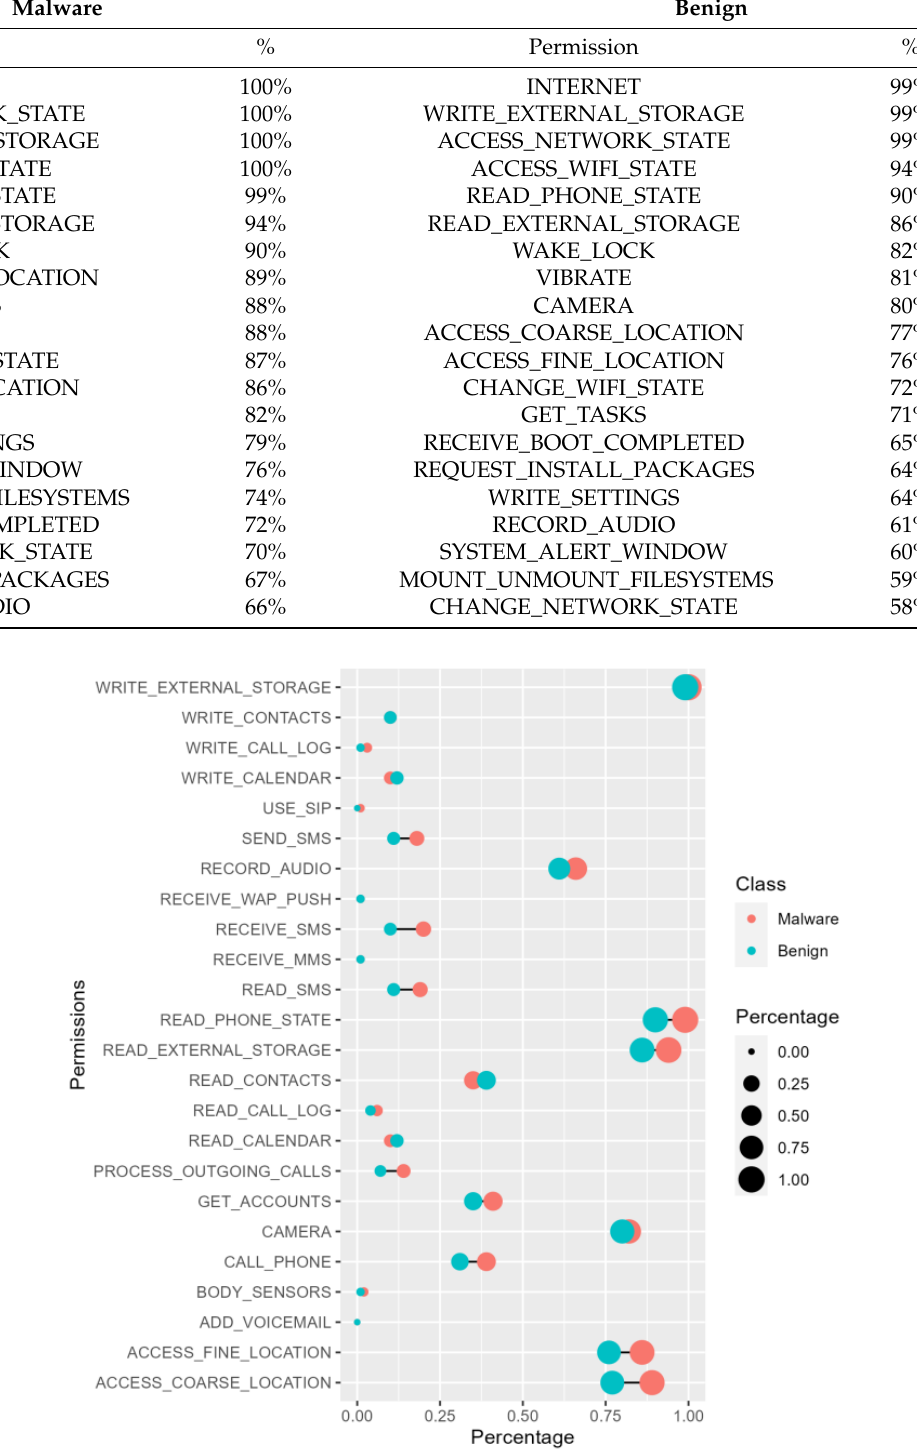
Table 6. Top 20 most common permissions in malicious and benign apps.